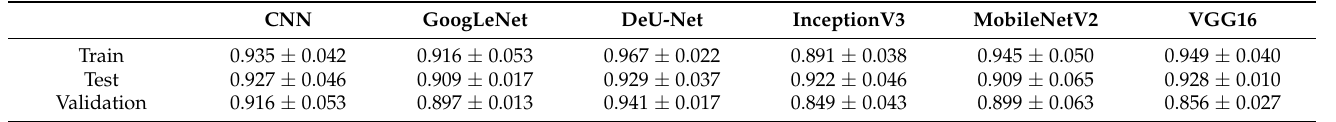
Table 6. Mean and SD of AUC with fusion